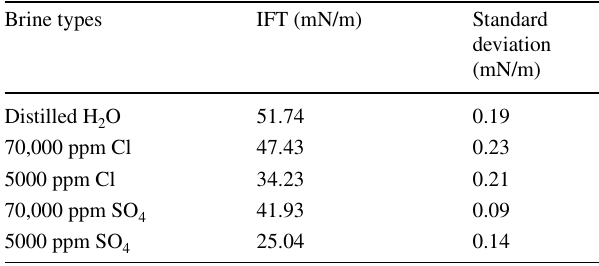
Table 6 IFT results of all brines at 1500 psig and 50 °C